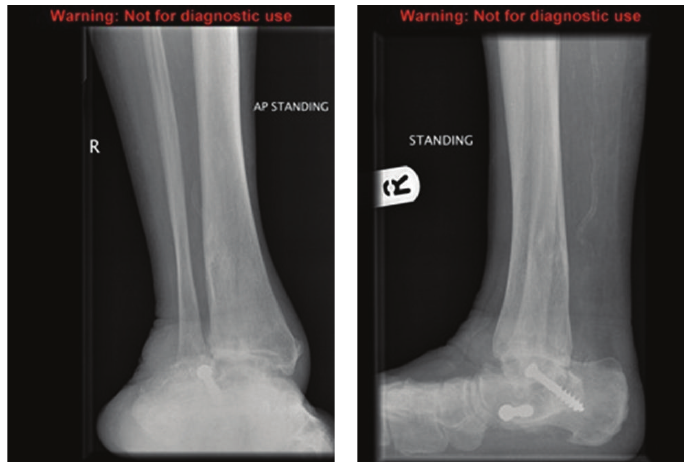
Figure 1: Preoperative radiograph demonstrating previous arthrodesis screws.